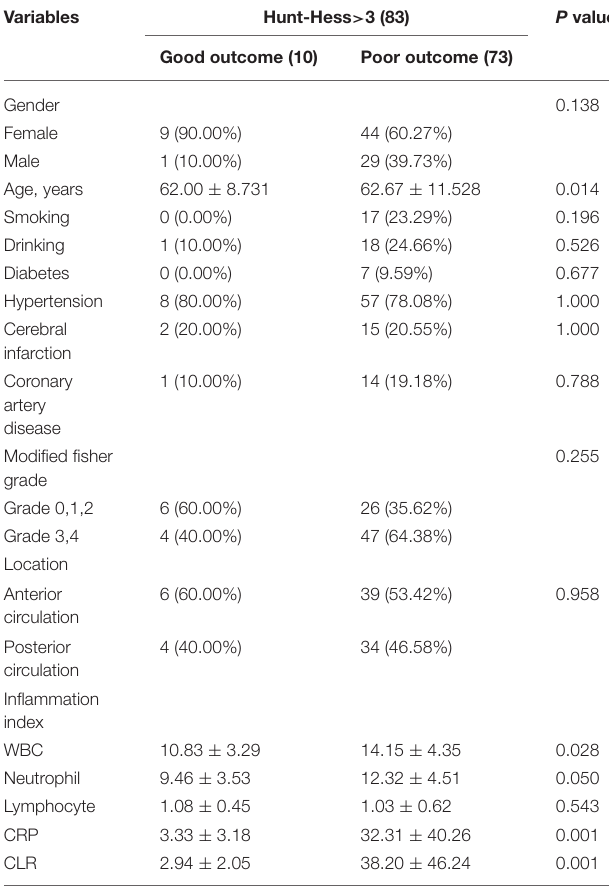
TABLE 3 | Univariate analysis of clinical characteristics of patients in mild and severe groups.